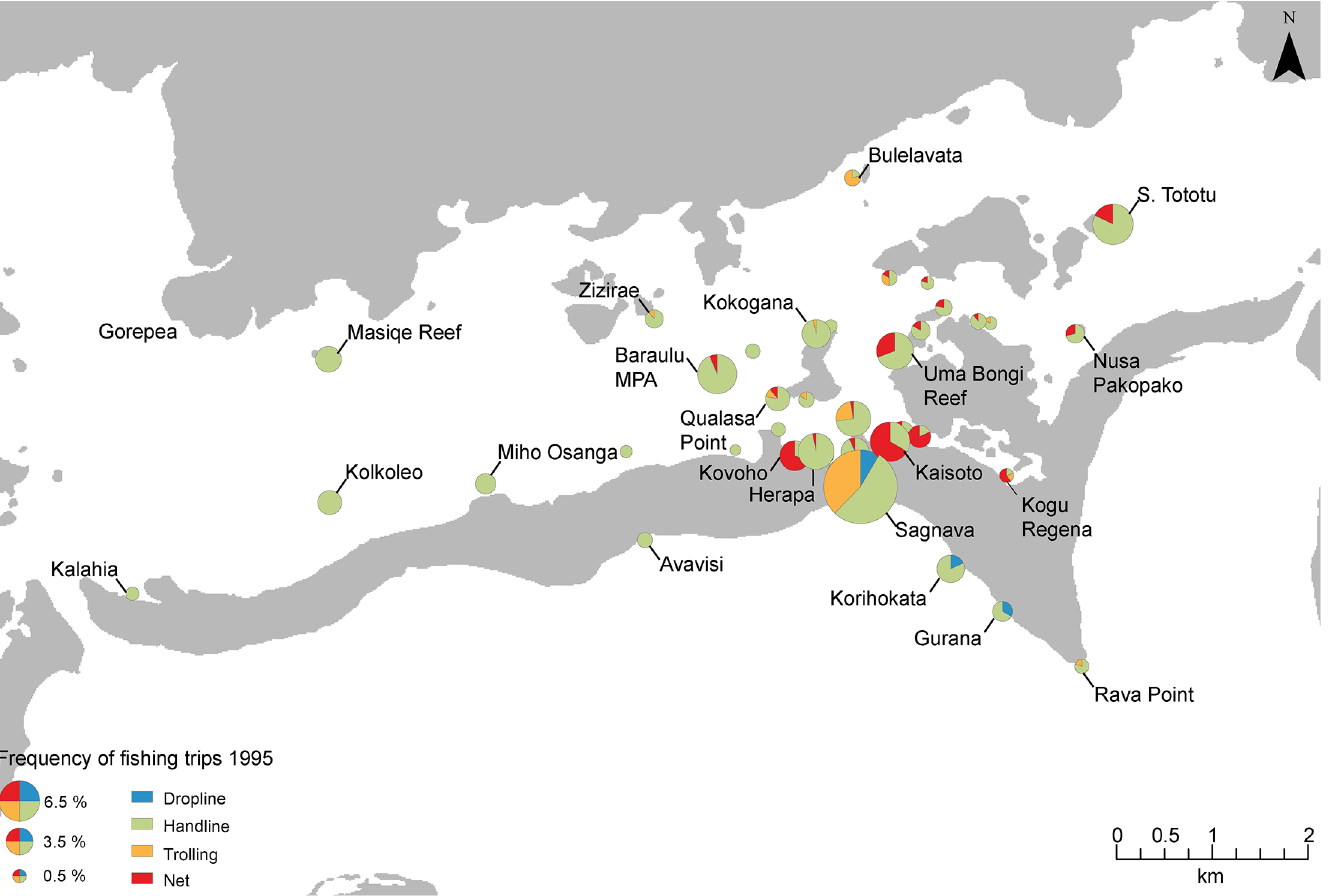
Fig 3. Proportion of fishing time and methods spent across fishing sites within the Roviana lagoon study area in 1995. Size of pie chart symbol denotes the the anmount of time spent at fishing locations throughout the Roviana lagoon during the 1995 record period. The amount of time spent for each method is shown by pie chart